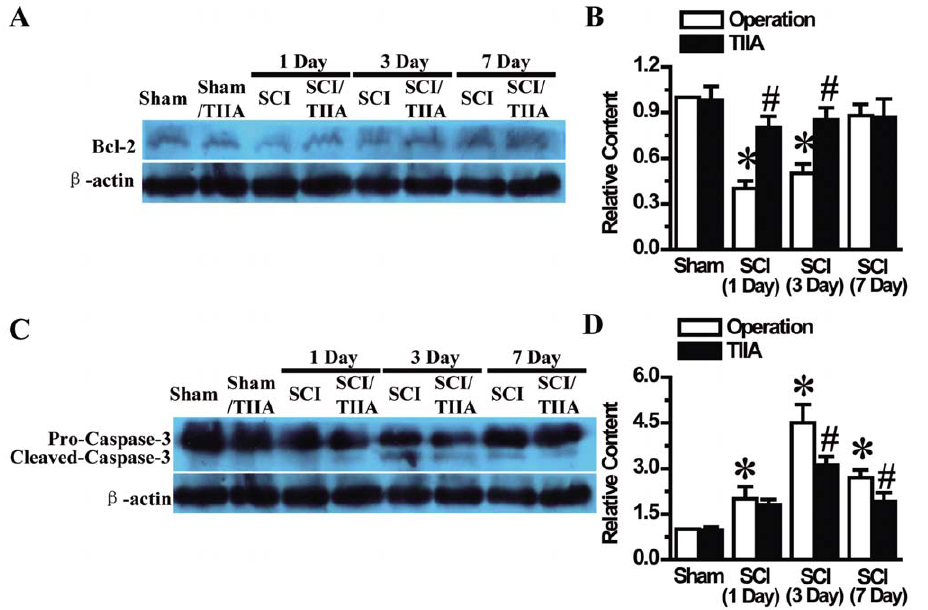
Figure 9. Effects of TIIA on apoptosis-related factors after SCI. The protein expression of Bcl-2 was reduced in the SCI group at 1 day and 3 days compared to the sham and sham/TIIA groups, whereas Bcl-2 was up-regulated in the SCI/TIIA group (A). The analyzed data are shown. (B) The cleaved caspase-3 expression began to increase at 1 day, peaked at 3 days and quickly reduced to a lower level at 7 days after SCI. However, TIIA treatment decreased the cleaved caspase-3 (C). The analyzed data are shown (D). Bars represent means 6 SEM. * p , 0.05 vs. sham group, # p , 0.05 vs. SCI group.